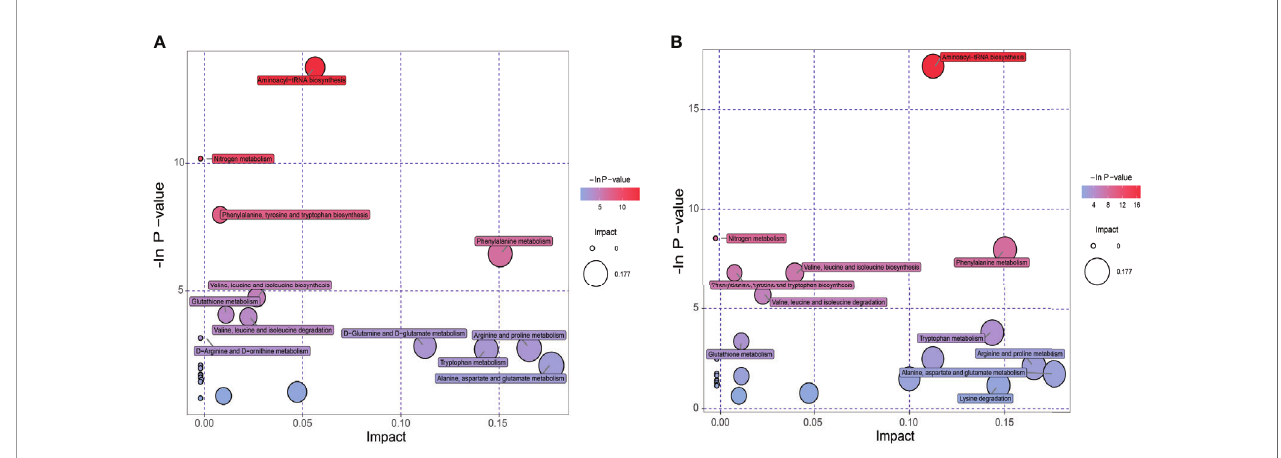
FIGURE 5 | Pathway analysis for group PCOS vs . PCOS-MS (A) and group HC vs. PCOS-MS (B)